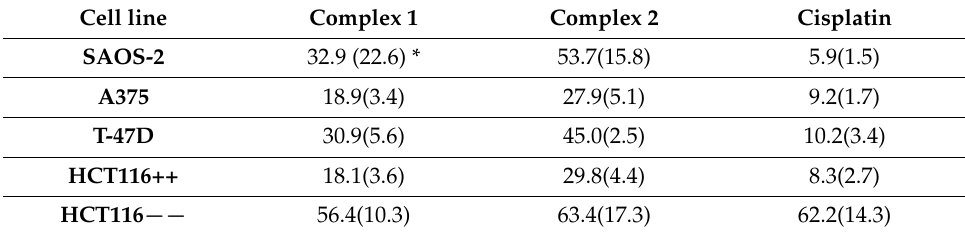
Table 2. IC 50 values for complexes 1 and 2 and cisplatin in five cancer cell lines. Data were collected after 96 h of exposure to the drugs. Standard deviation is shown in brackets.